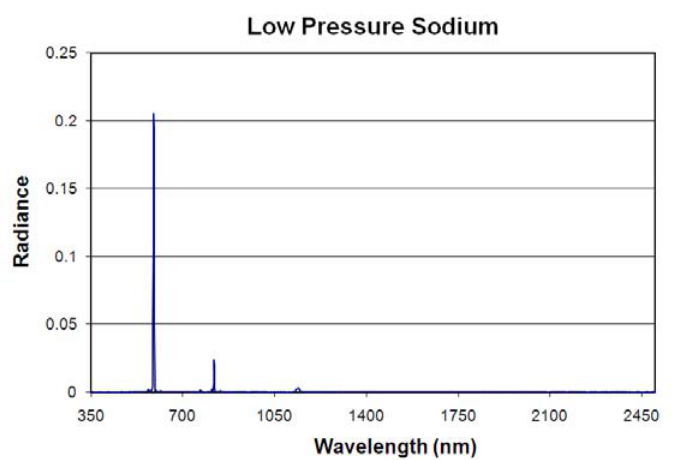
Figure 16. Emission spectrum of a low pressure sodium lamp.